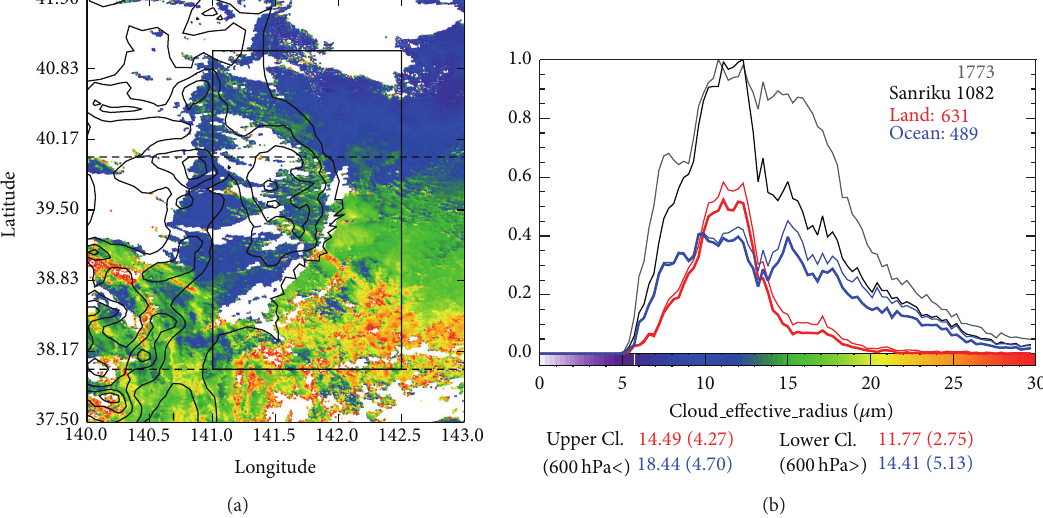
Figure 8: Same as Figure 4 but at 0335 UTC August 16, 2003. The thick (thin) red and blue lines indicate the distributions of the lower (upper) cloud over land and ocean, respectively.